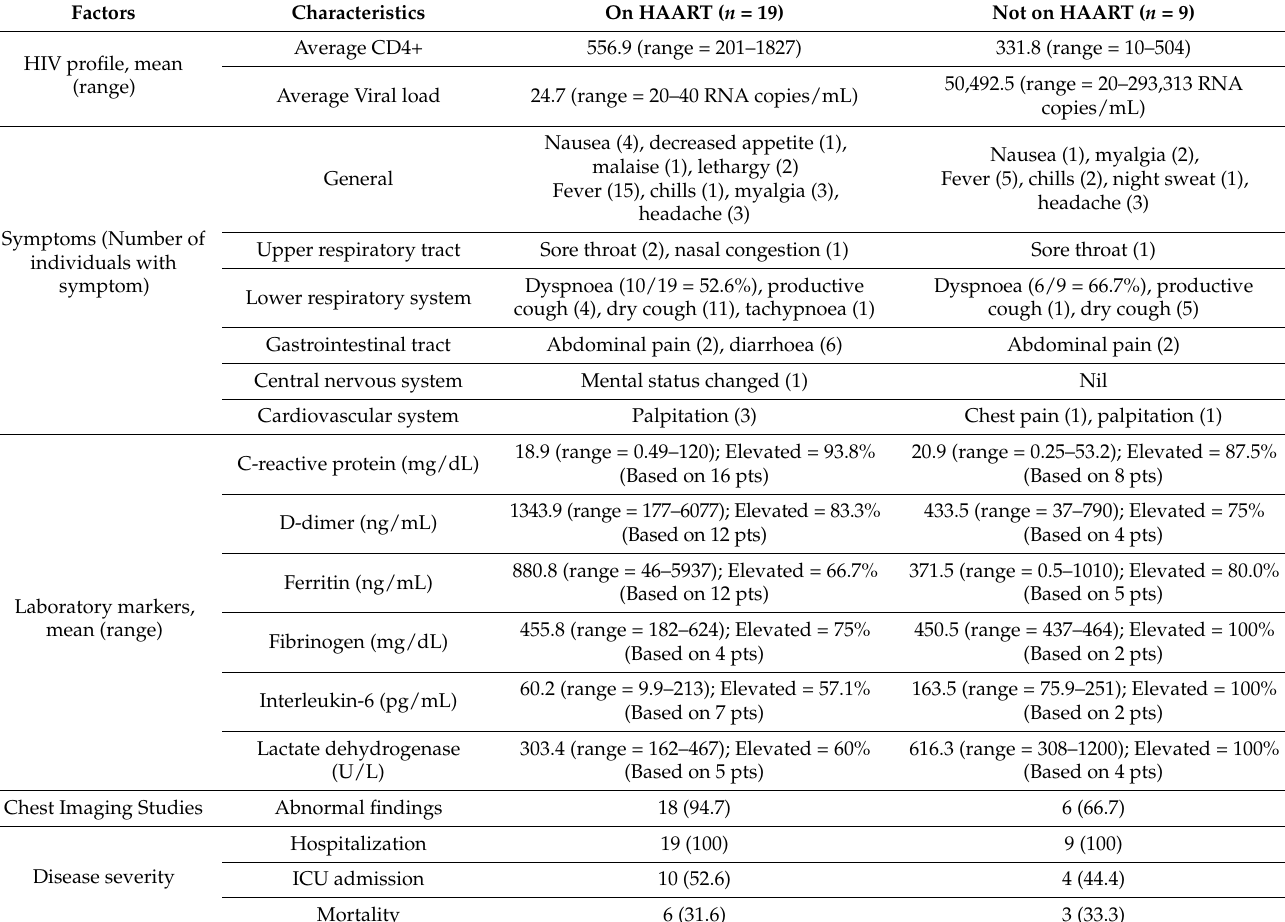
Table 4. Subgroup analysis on characteristics of PLHIV co-infected with COVID-19 adherence to Highly active antiretroviral therapy